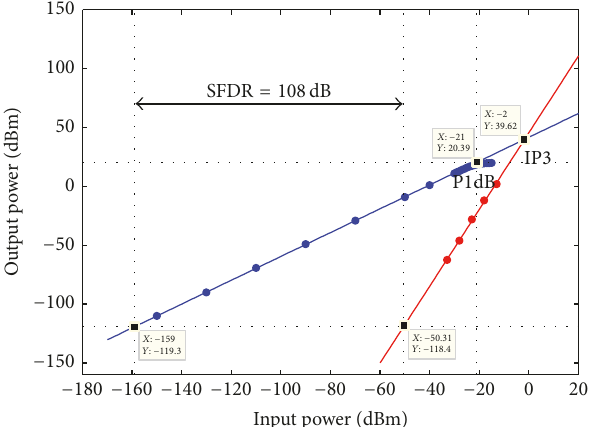
Figure 3: The linear gain and third-order intermodulation distortion (IMD3) of the AFE.